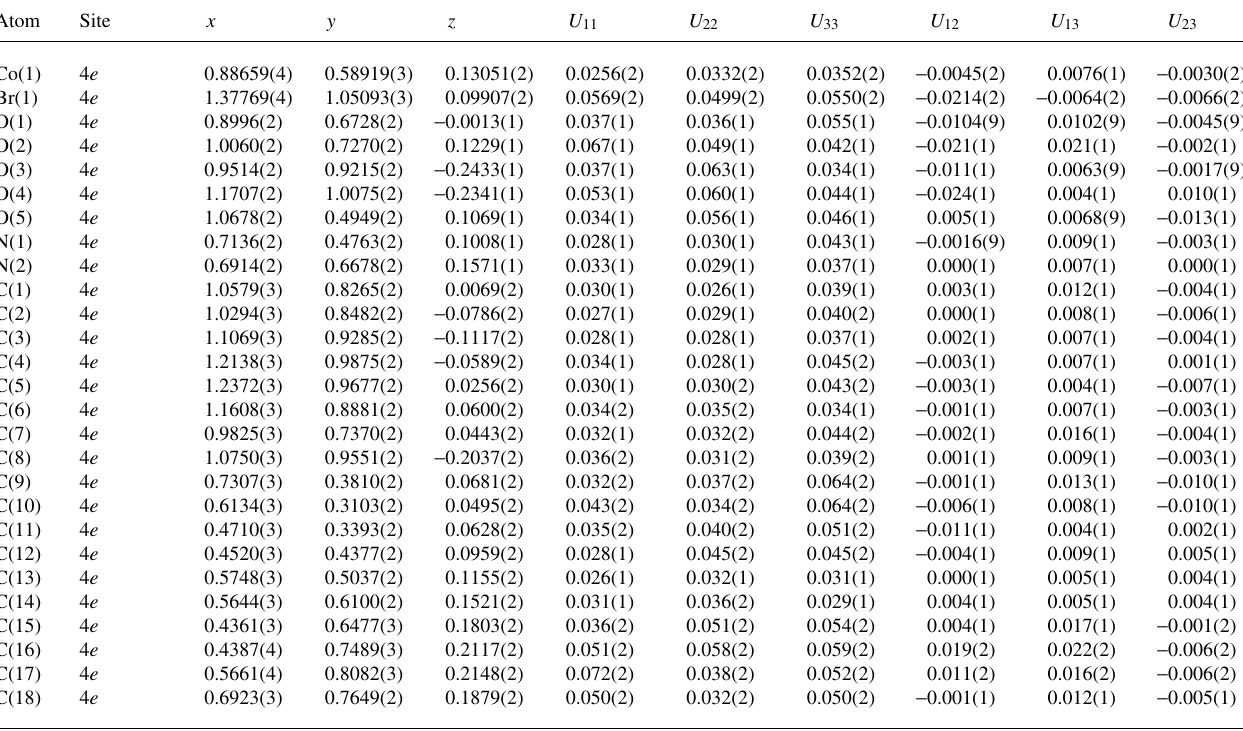
Table 3. Atomic coordinates and displacement parameters (in Å 2 )